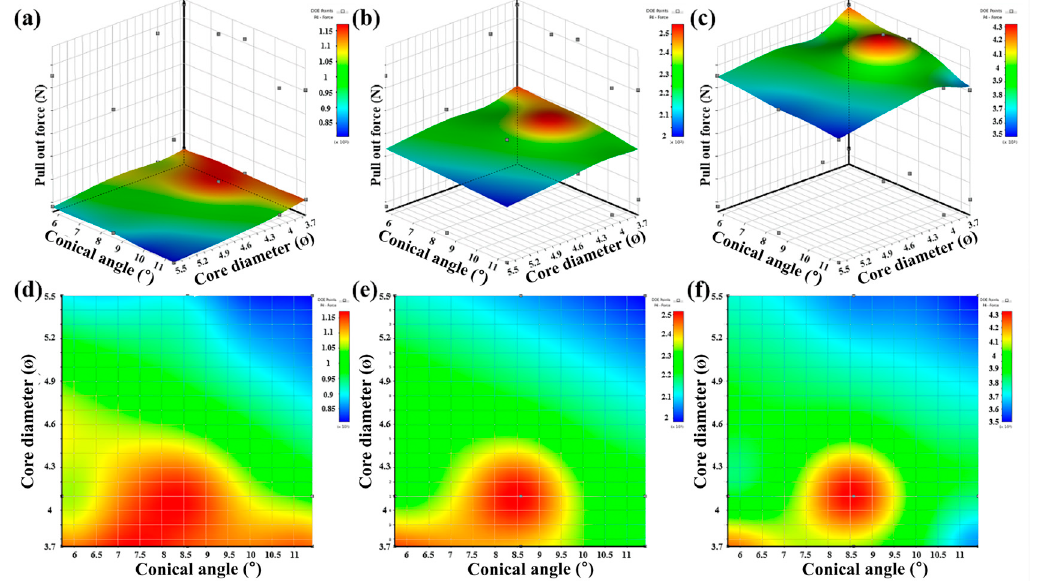
Figure 12. 3D and 2D response surface plot of the pullout force with variables of the pedicle screw and density: ( a ) and ( d ) grade 10 ( b ) and ( e ) medium density of grades 10 and 20, and ( c ) and ( f ) grade 20.